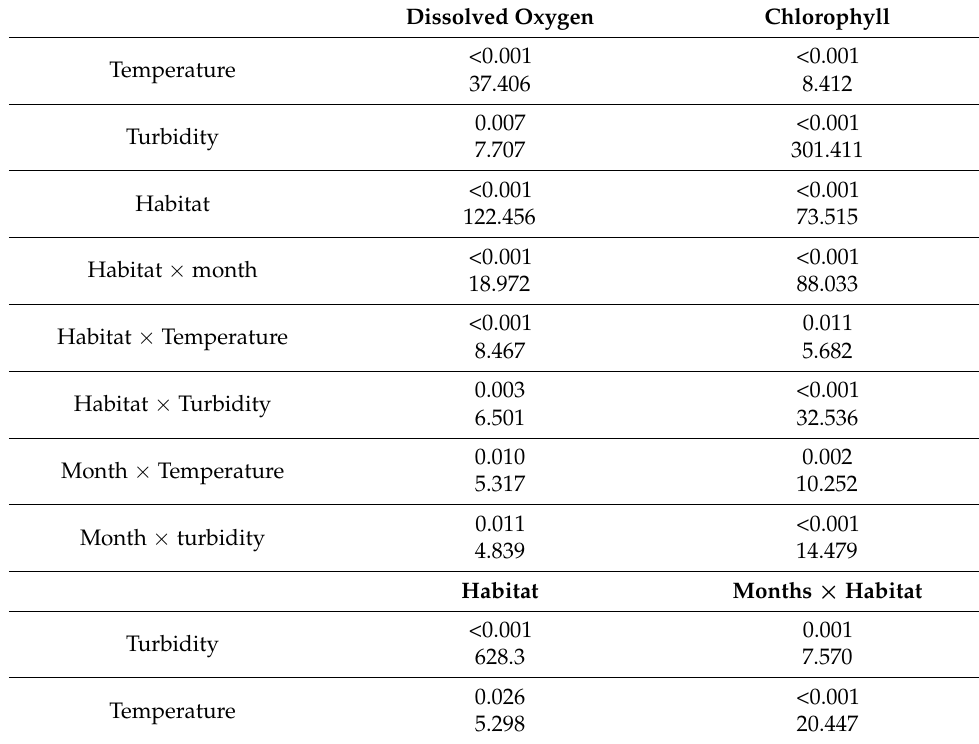
Table 1. Analysis of variance (ANOVA) evaluates the significance of the environment variable and the interaction between the latter variable and the month variable for all four chemical-physical parameters. In the specific case of dissolved oxygen and chlorophyll, the impact of temperature, turbidity, and their respective interactions with the environment and month variables is evaluated. Top: p -values. Bottom: